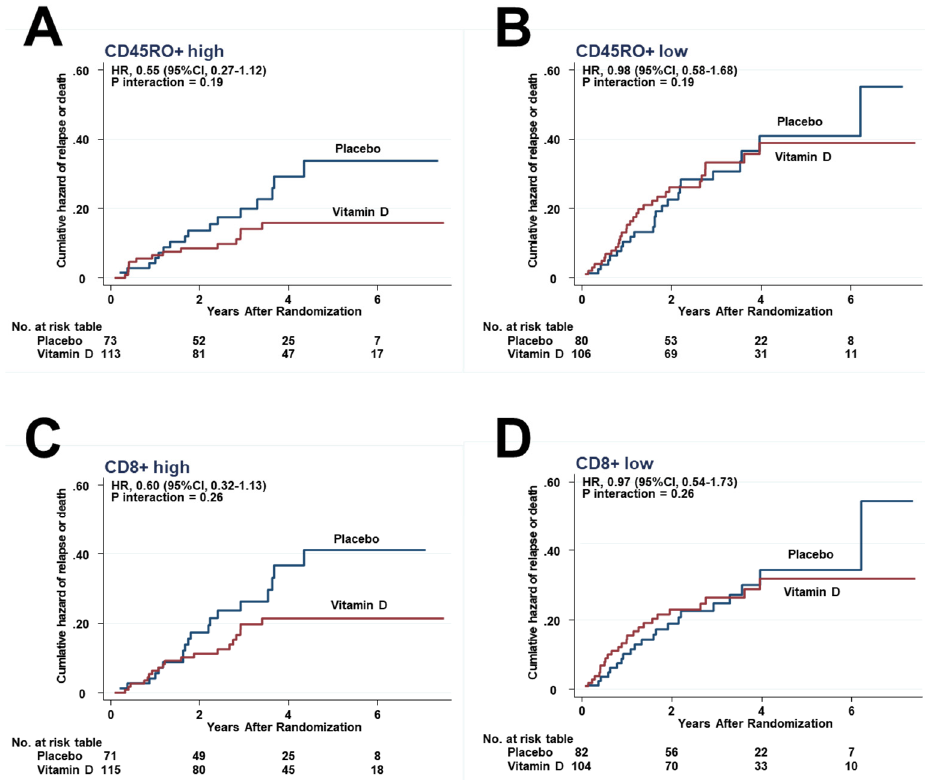
Figure 6. Effect of vitamin D on relapse or death in the subgroups of ( A ) CD45RO+ higher half, ( B ) CD45RO+ lower half, ( C ) CD8+ higher half, and ( D ) CD8+ lower half.